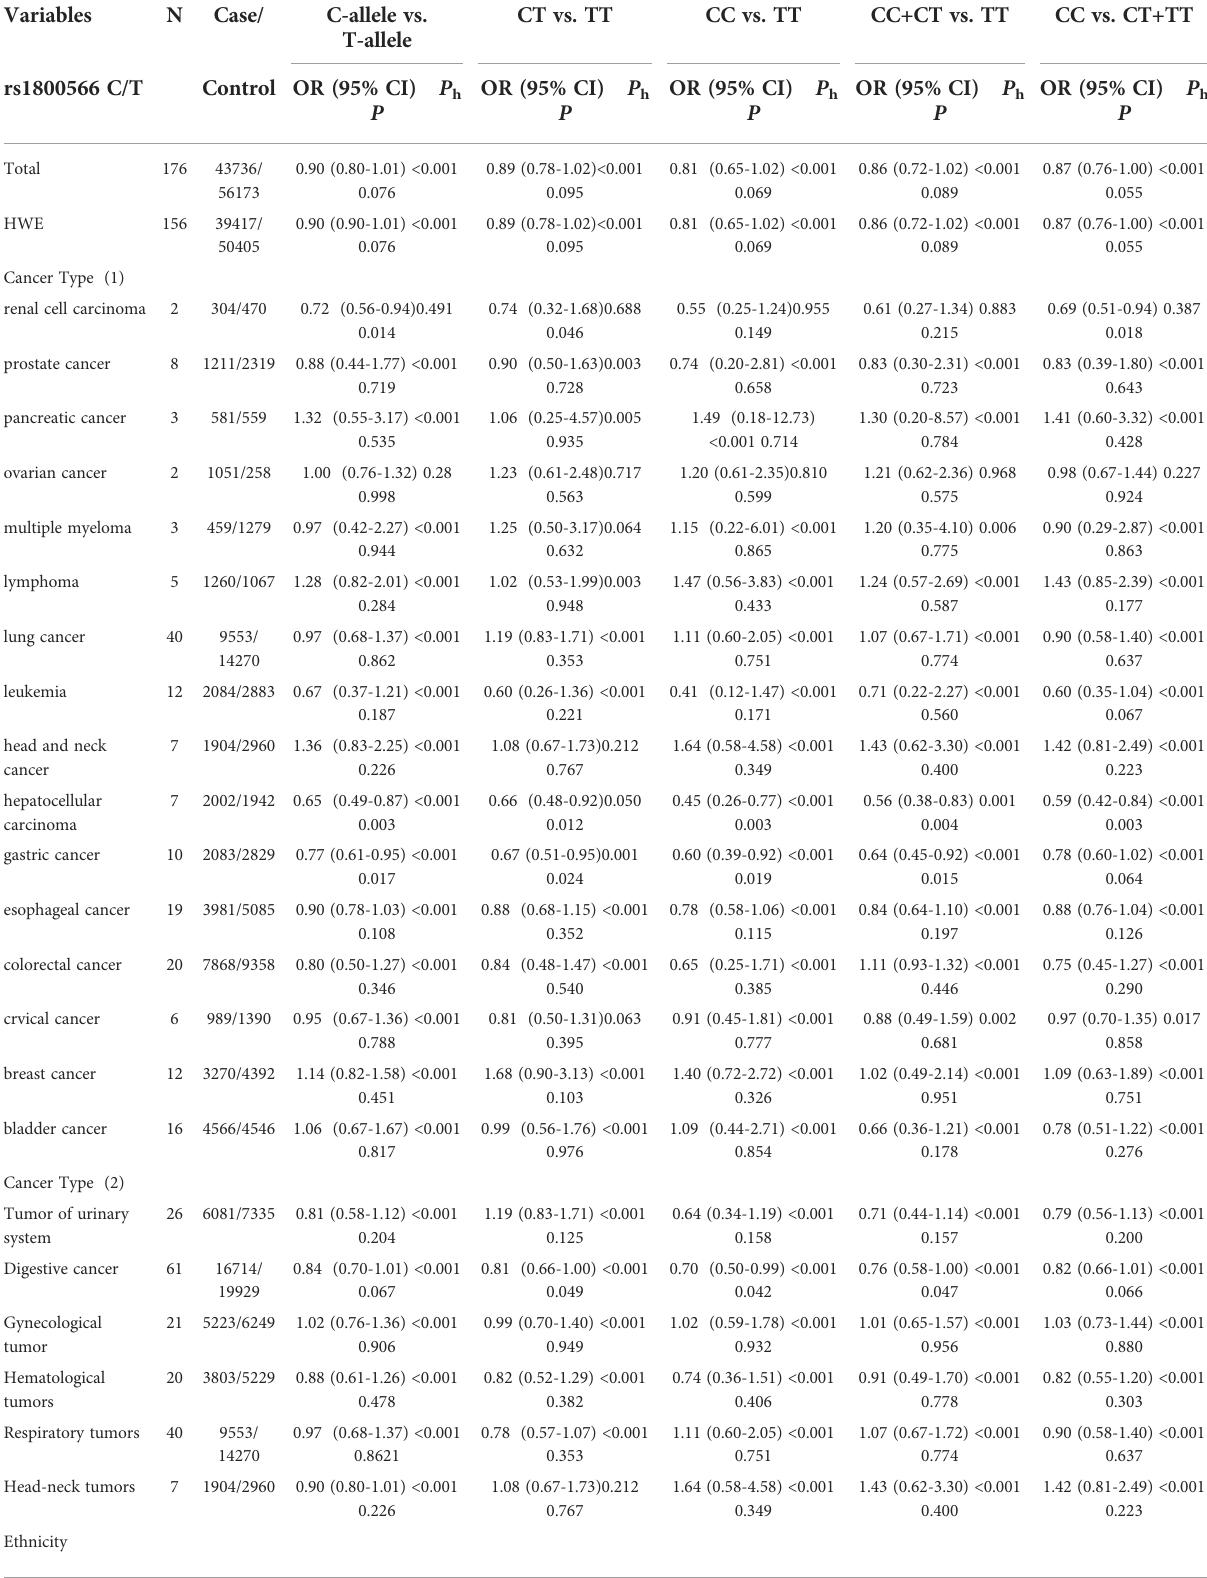
TABLE 1 Strati fi ed analysis of NQO1 rs1800566 C/T variation on cancer